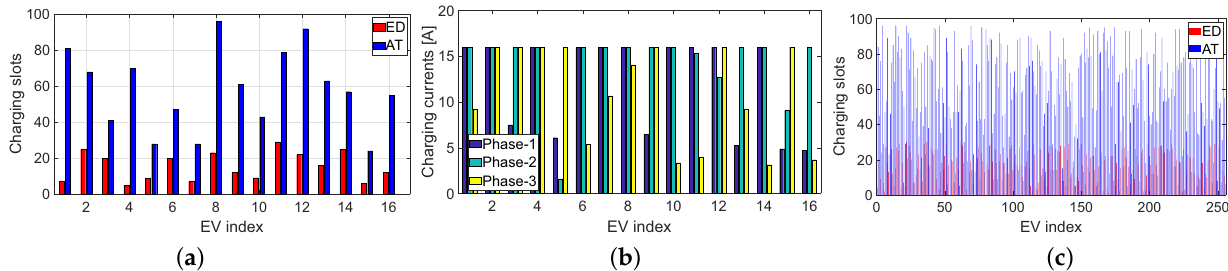
Figure 3. Charging settings: ( a ) ED and AT parameters for N = 16 and random charging rates; ( b ) charging rates for N = 16; ( c ) ED and AT parameters for N = 256 and a constant charging rate.